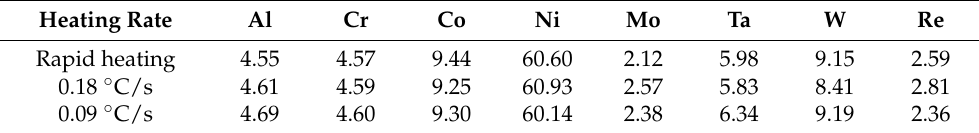
Table 4. Chemical composition (mass fraction%) of matrix phase at three heating rates. Heating